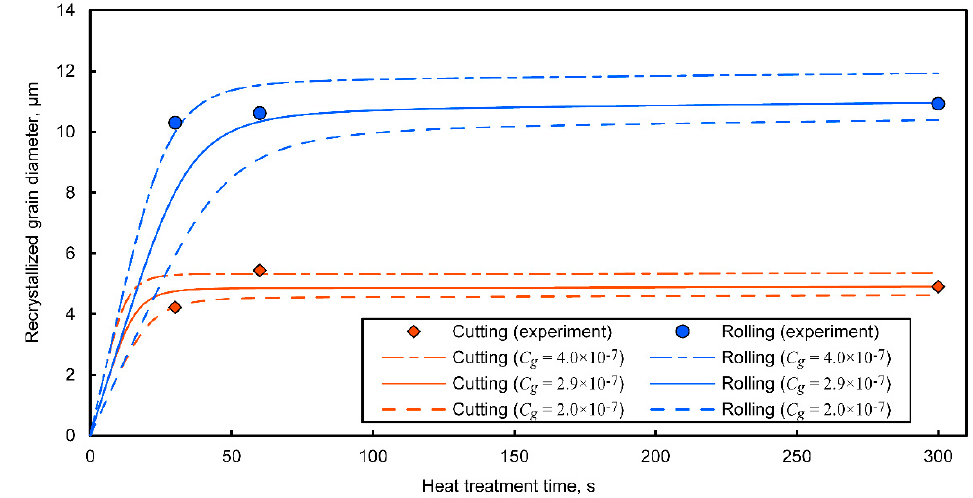
Figure 13. Effect of the parameter on recrystallization simulation and results of parameter fitting for 600 °C heat treatment. Table 4. Fitting parameters of recrystallization simulation at 600 °C.